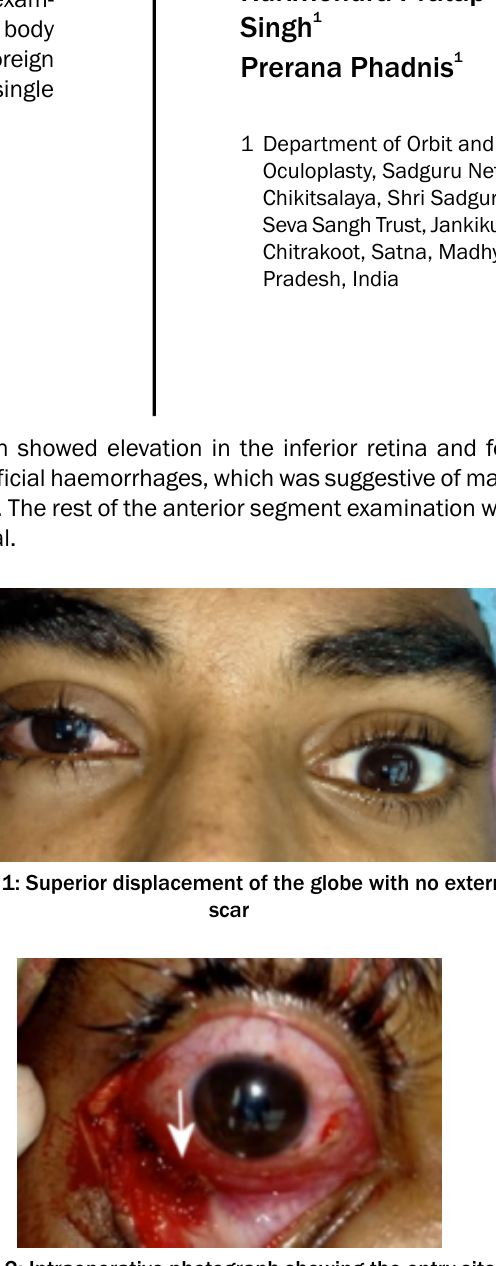
Figure 2: Intraoperative photograph showing the entry site in the inferior fornix (arrow) Computed tomography revealed a well-defined, linear, hypodense, air-filled tract suggestive of a foreign body in the inferior orbit extending to the maxillary